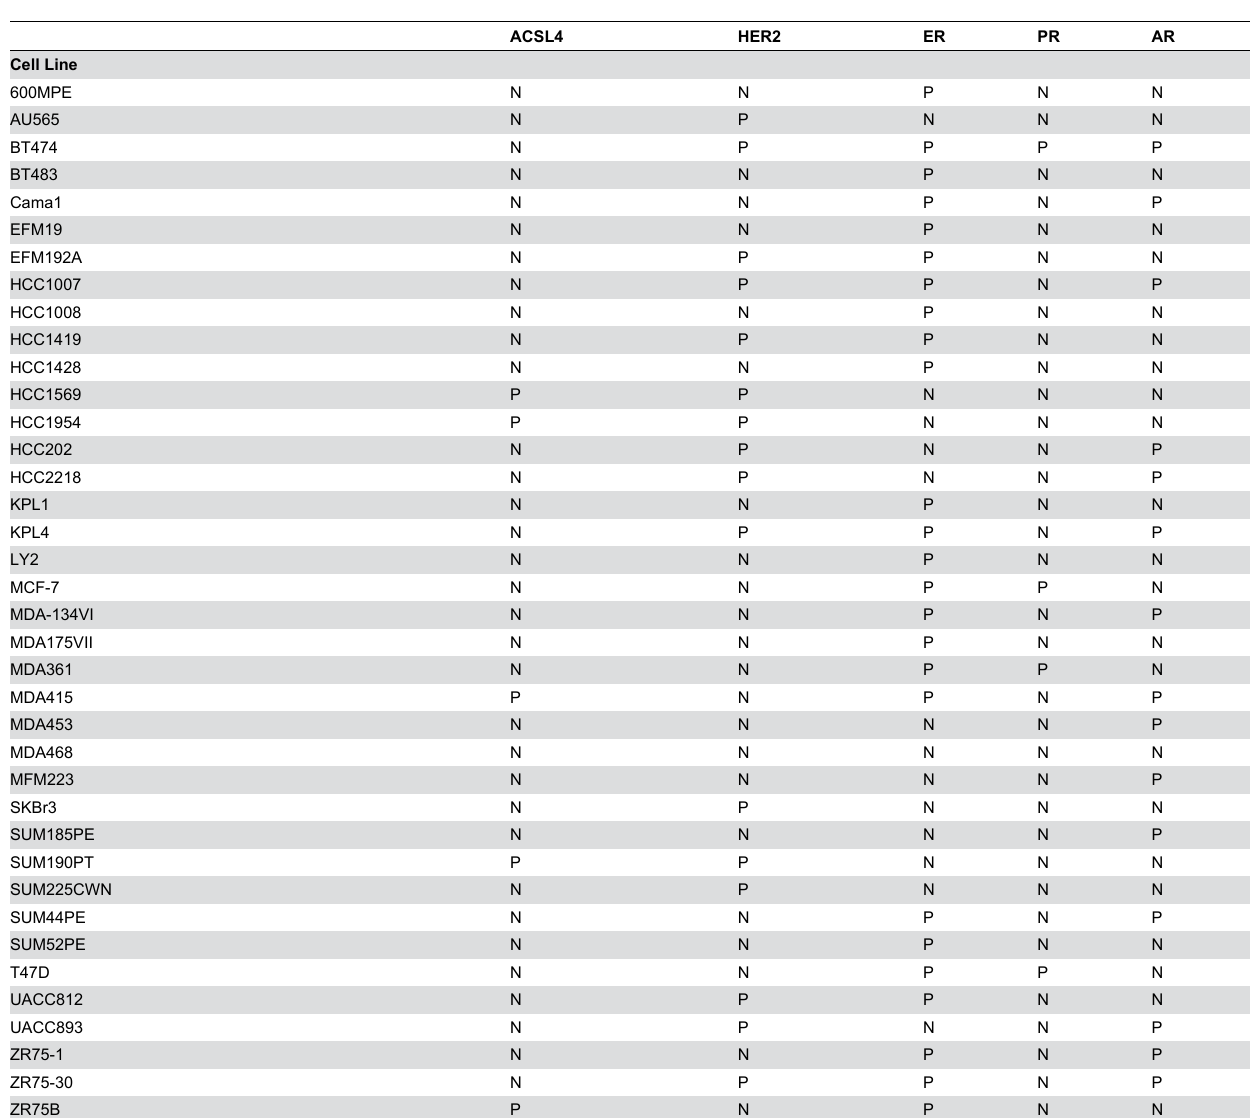
Table 2. ACSL4 expression in steroid hormone/HER2 receptor positive breast cancer cell